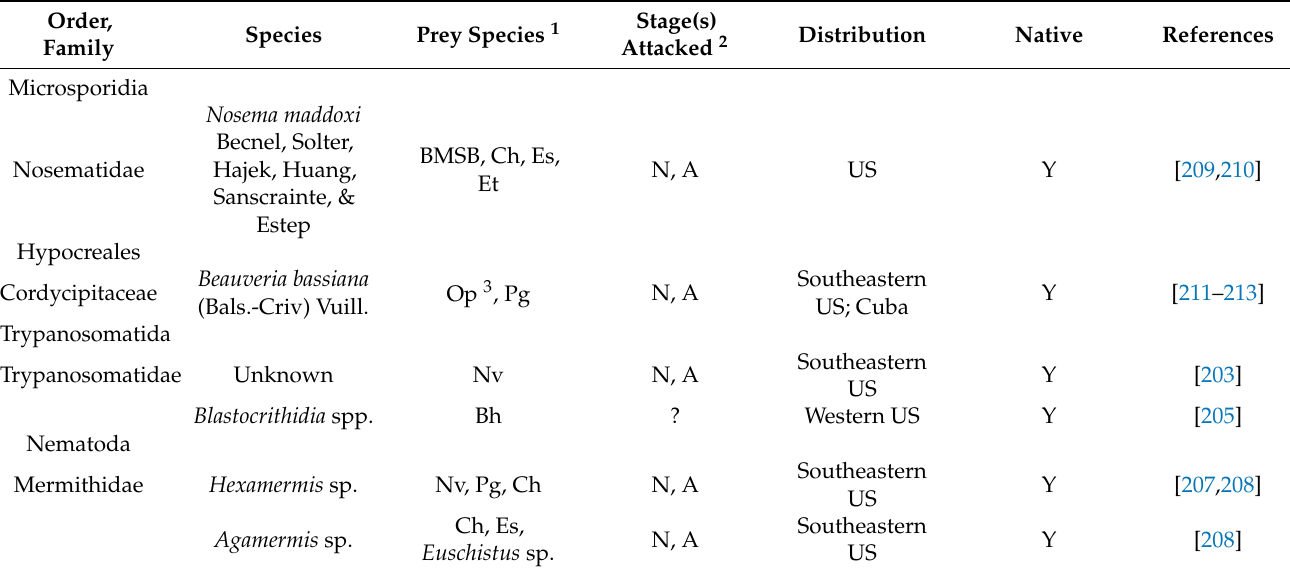
Table 3. Pathogens of stink bugs reported in North America, with hosts, stages attacked, and coarse